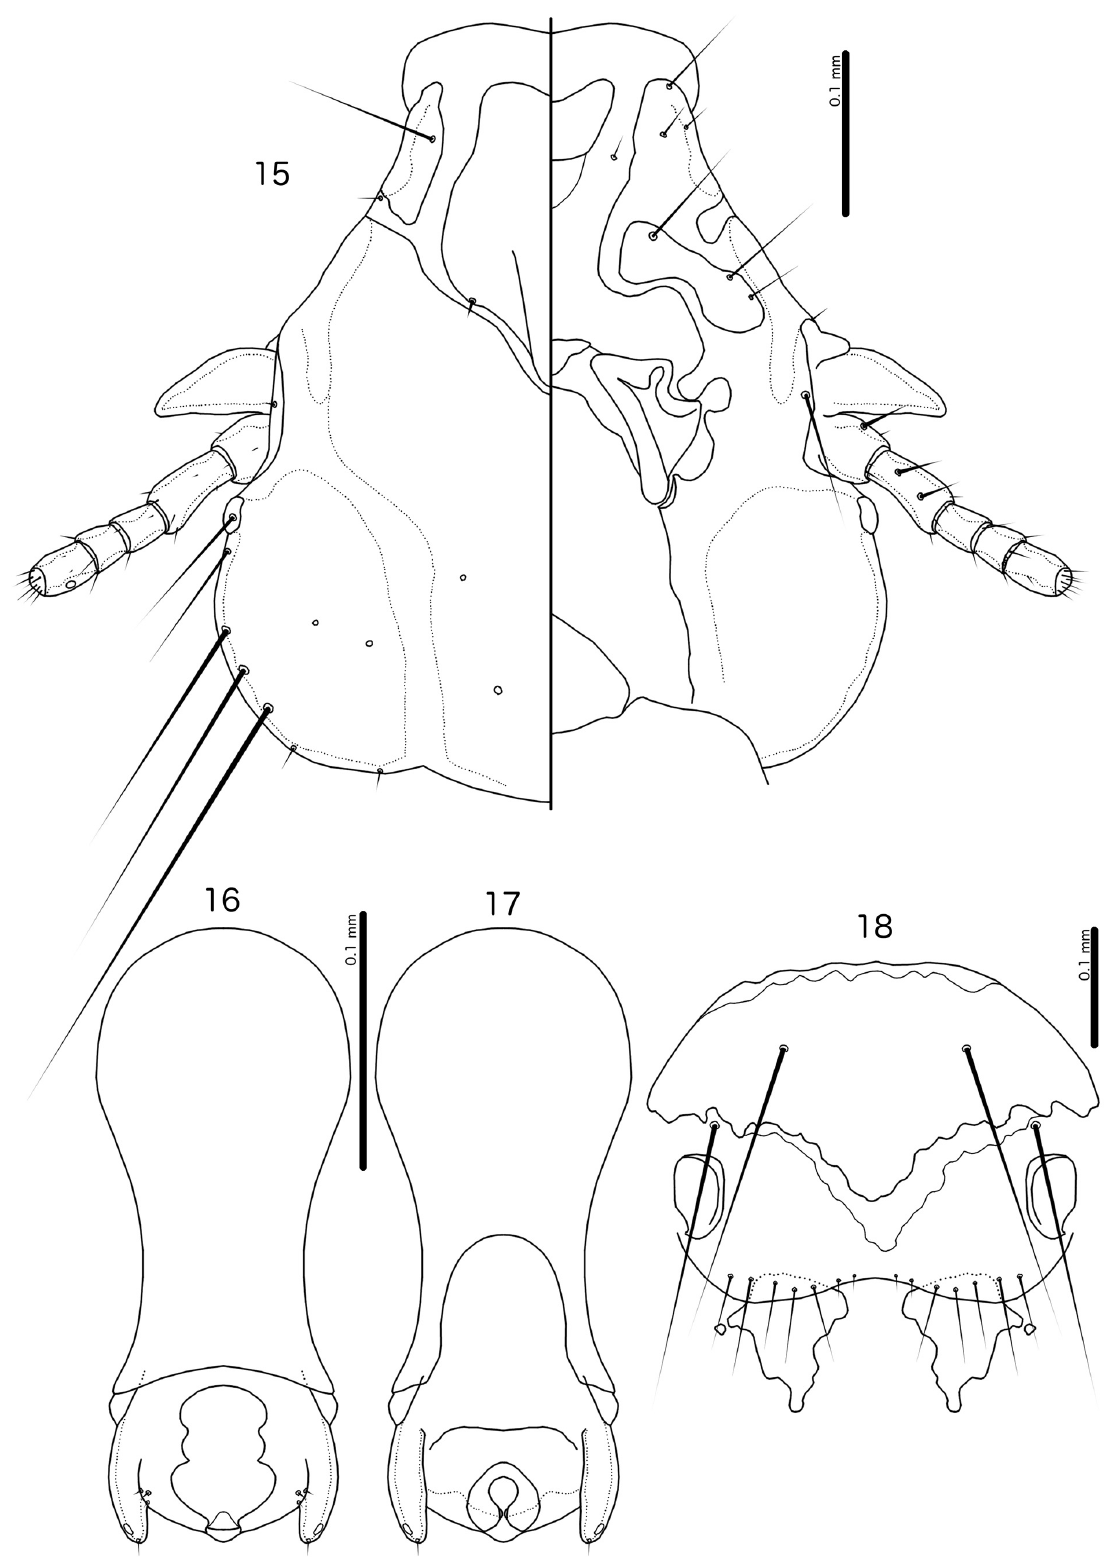
Figs 15–18. Philopterus afropari sp. nov. ex Melaniparus cinerascens cinerascens (Vieillot, 1818). 15 . Male head, dorsal and ventral views. 16 . Male genitalia, dorsal view. 17 . Male genitalia, ventral view. 18 . Female subgenital plate, vulval margin, and subvulval plates, ventral